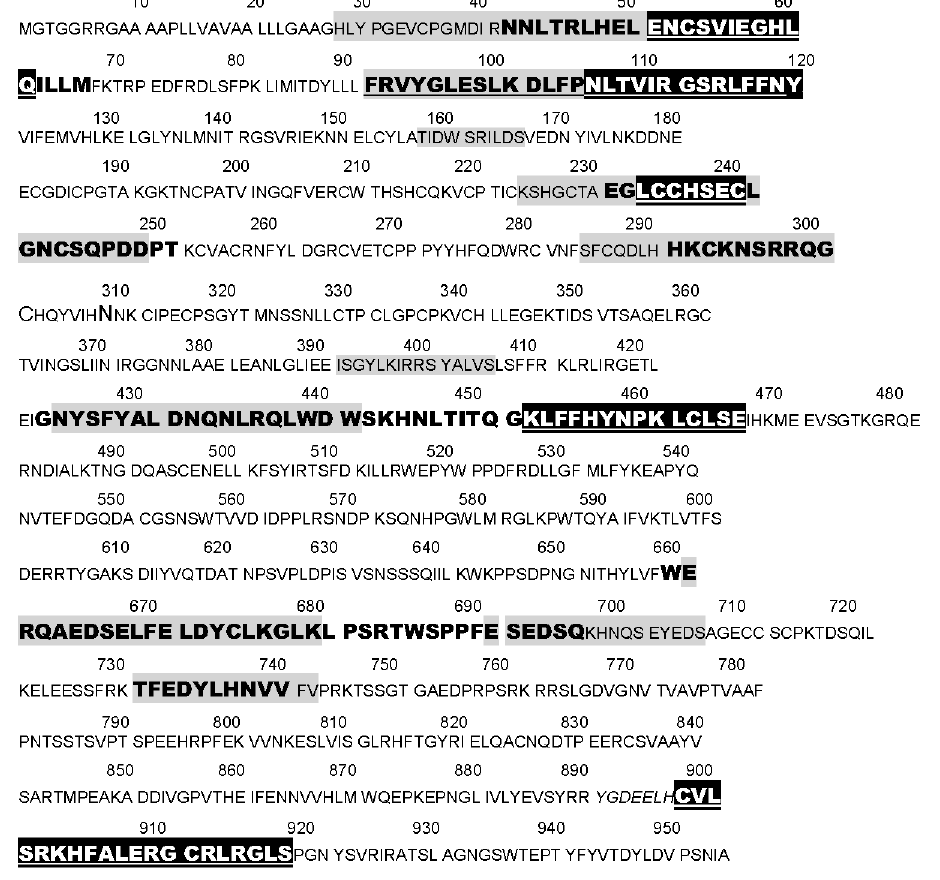
Figure 2. Annotated sequence of the extracellular (amino acids 1–956) portion of the insulin receptor (IR) (UniProt P06213 at www.expasy.org) summarizing where various types of studies have identified insulin binding regions. Bold letters represent sequences for which several techniques (alanine substitutions, blocking antibodies, photo-crosslinking studies—reviewed in [42]) have demonstrated insulin binding. Regions highlighted in black with white lettering mimic insulin and bind glucose (reviewed in [42]). Regions highlighted in grey mimic glucagon. Underlined regions are those that bind insulin-HRP in the present study.